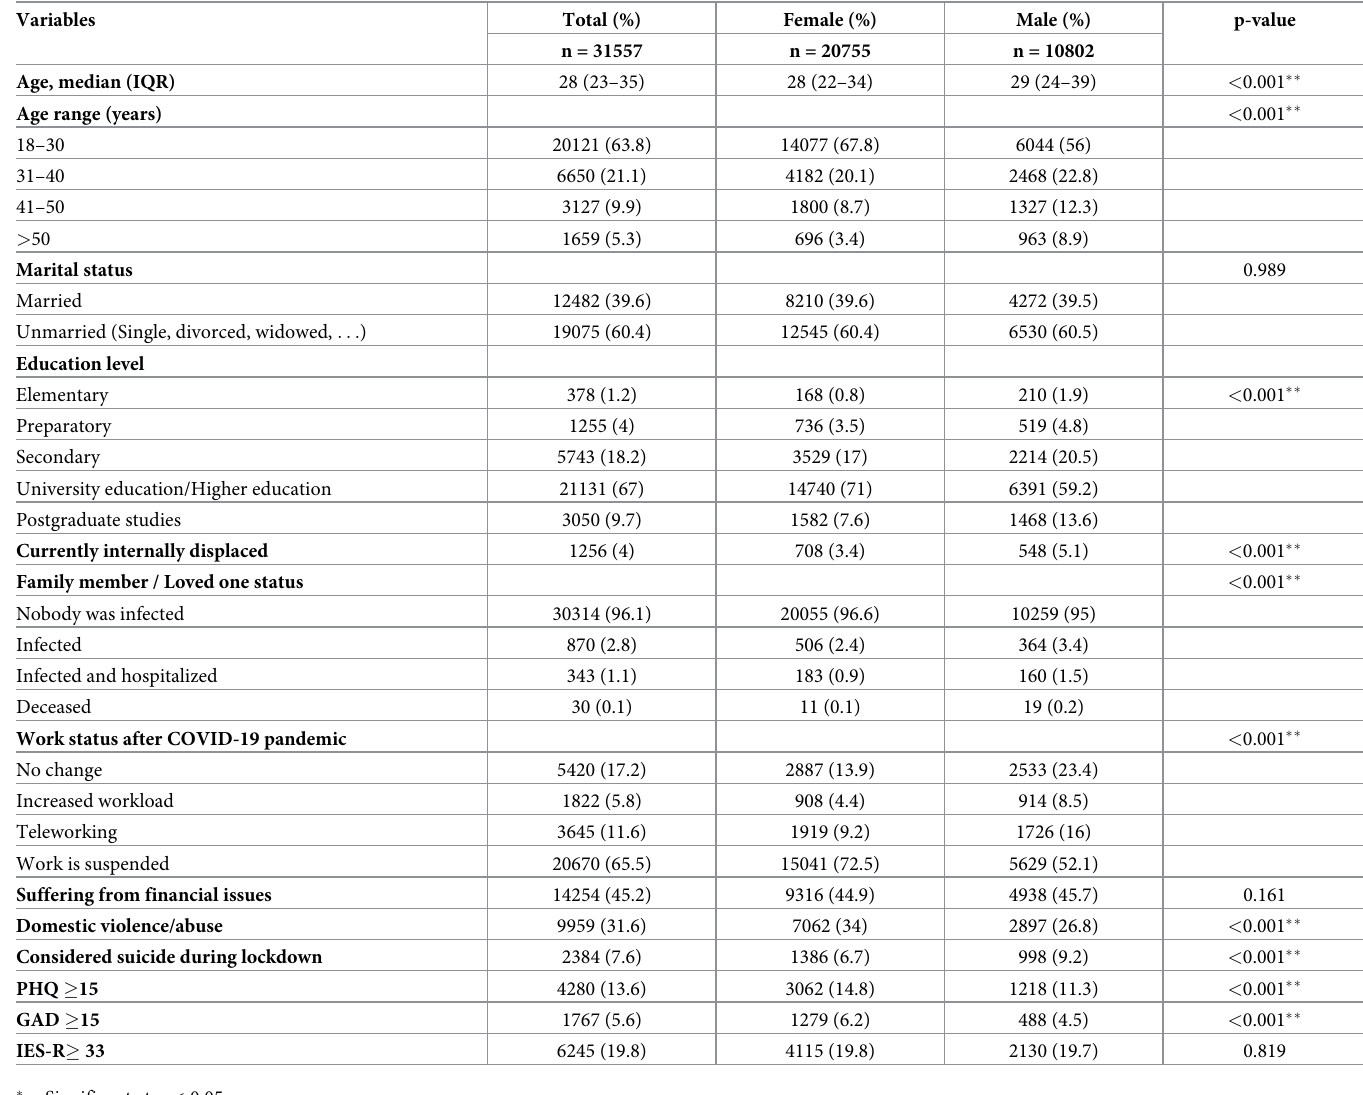
Table 1. Basic characteristics of study participants (n =